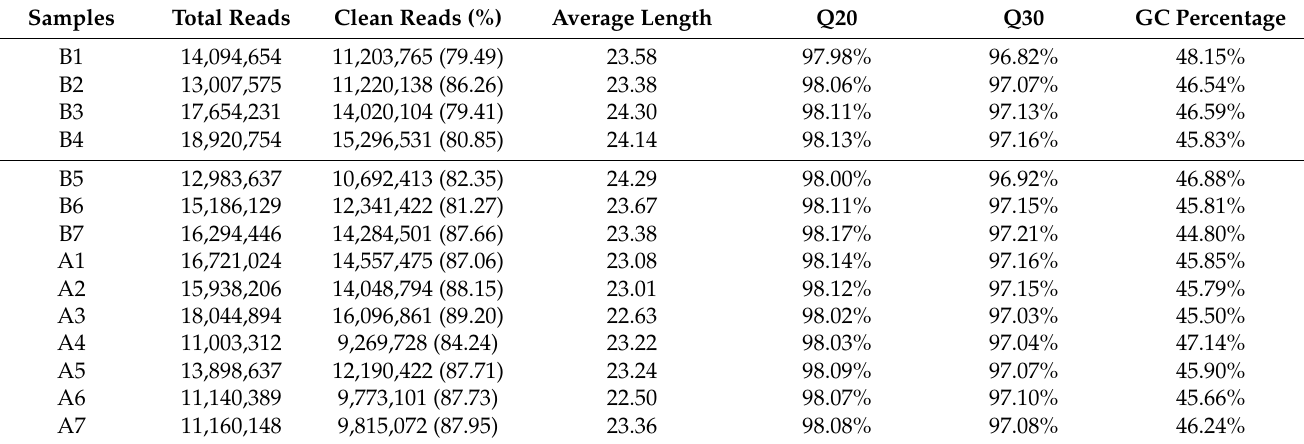
Table 2. Quality control summary of miRNA-seq